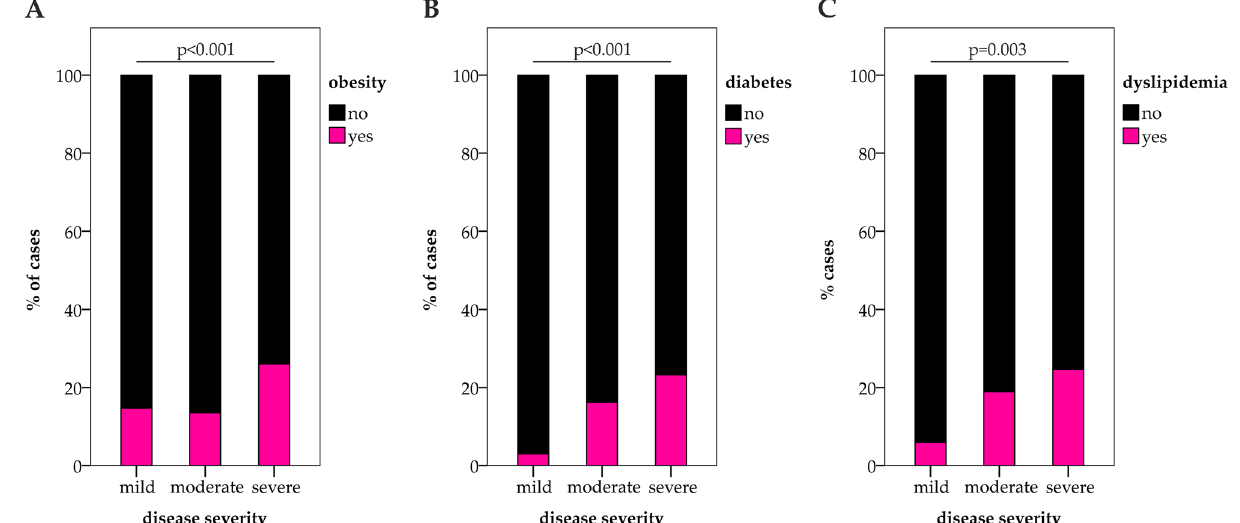
Figure 1. Preexisting metabolic comorbidities are related to the course of acute COVID-19. Bars depict the prevalence of obesity ( A ), diabetes mellitus ( B ), and dyslipidemia ( C ) before COVID-19 onset in patients with mild, moderate and severe acute COVID-19. N total = 145, N mild = 34, N moderate = 38, N severe = 73. P -values are reported according to Chi-Square tests.